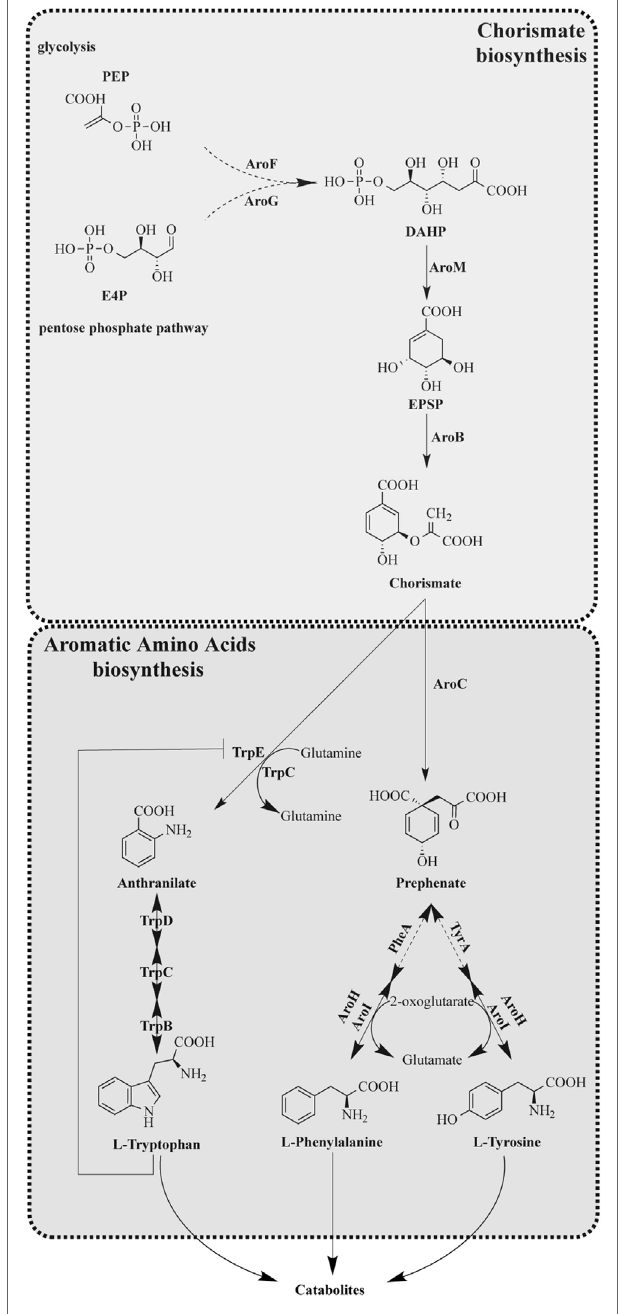
FiGURe 1 | Tryptophan anabolism of Aspergillus fumigatus. [Modified from that of Wang et al. (28)]. Solid arrows indicate characterized reaction as being present in A. fumigatus with product detected. Dashed arrows indicate uncharacterized reactions; however, putative orthologs are present in A.